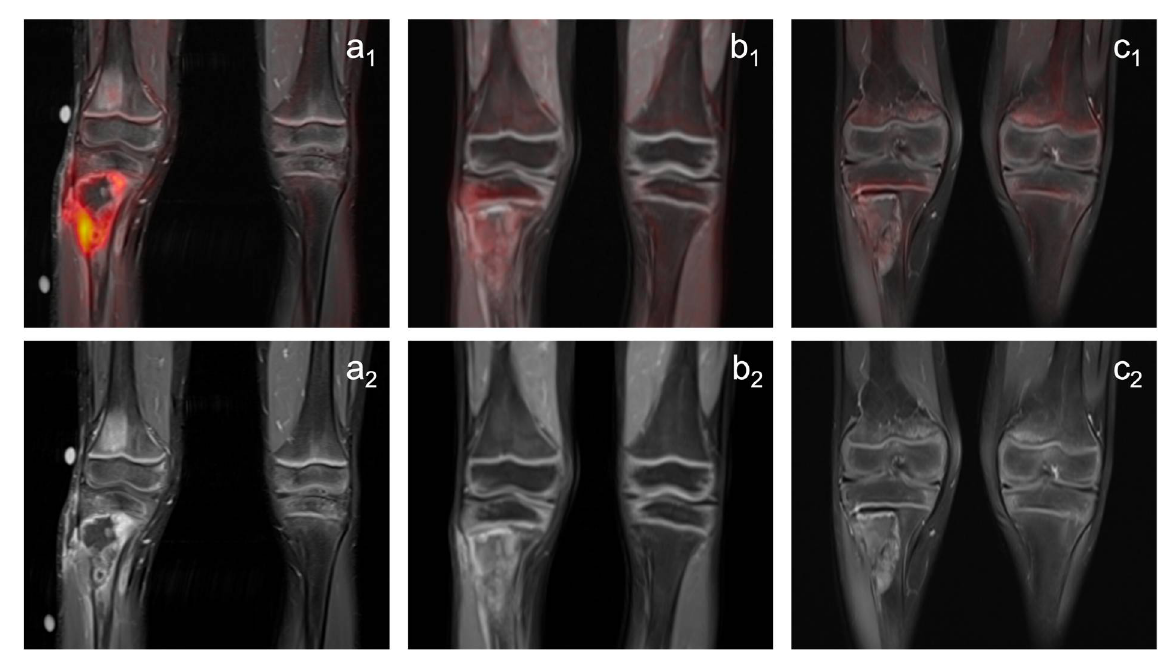
Figure 2. Images of a patient with a Ewing sarcoma in the proximal right tibia (74 mm), which shows a pathological tumor metabolism (SUVpeak: 4,1) at the pretherapeutic examination (( a 1 ): PET/MRI, ( a 2 ) MRI). The tumor reveals a significant decrease in metabolic activity under treatment (PET/MRI; ( b 1 ): first follow-up, SUVpeak: 1,5 (−63.4%); ( c 1 ): second follow-up, SUVpeak: 1,2 (−70.7%)), combined with a moderate decrease in size (MRI; ( b 2 ): first follow-up, 51 mm (−31,1%); ( c 2 ): second follow-up, 41 mm (−44.6%)). Histopathological analysis after subsequent tumor resection revealed remaining vital tumor (reference standard: partial response).